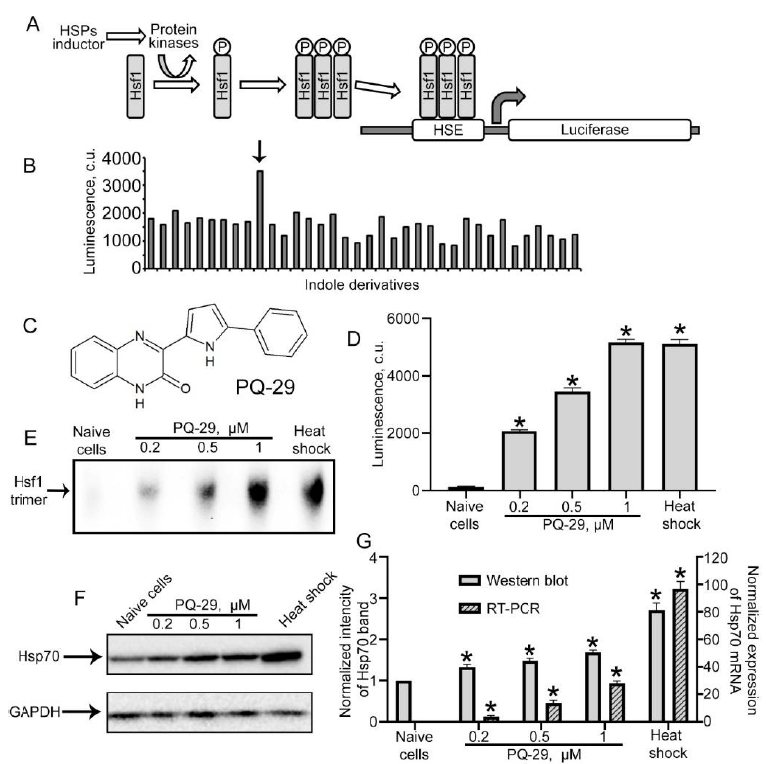
Figure 1. Searching for a new Hsp70 synthesis inducer. ( A ) The general scheme of the test system that we used for screening. ( B ) Typical screening result. The arrow marks the positive compound. ( C ) The chemical formula of the Hsp70 inductor PQ-29. ( D ) The result of the action of PQ-29 on C6-luc cells. Histogram bars illustrate the luciferase activity in cells. ( E ) Data of the Hsf1 trimer analysis. ( F ) Immunoblotting data. C6 cells were treated with PQ-29 in concentrations marked on the figure. Cells were analyzed 18 h after PQ-29 addition. Glyceraldehyde-3-phosphate dehydrogenase (GAPDH) is presented as a loading control. ( G ) The data of real-time polymerase chain reaction (RT-PCR) analysis and the data of immunoblotting quantification are presented. Non-patterned histogram bars show the relative intensity of Hsp70 band from F to intensity of GAPDH band normalized to this meaning for naïve cells accordingly to left Y-axis. Patterned histogram bars show the relative amount of mRNA transcribed from the hsp70 gene in C6 cells one hour after PQ-29 addition normalized to the amount of GAPDH mRNA accordingly to right Y-axis. Data presented as mean ± standard error of mean (SEM). Statistical significance is indicated as * p < 0.05.